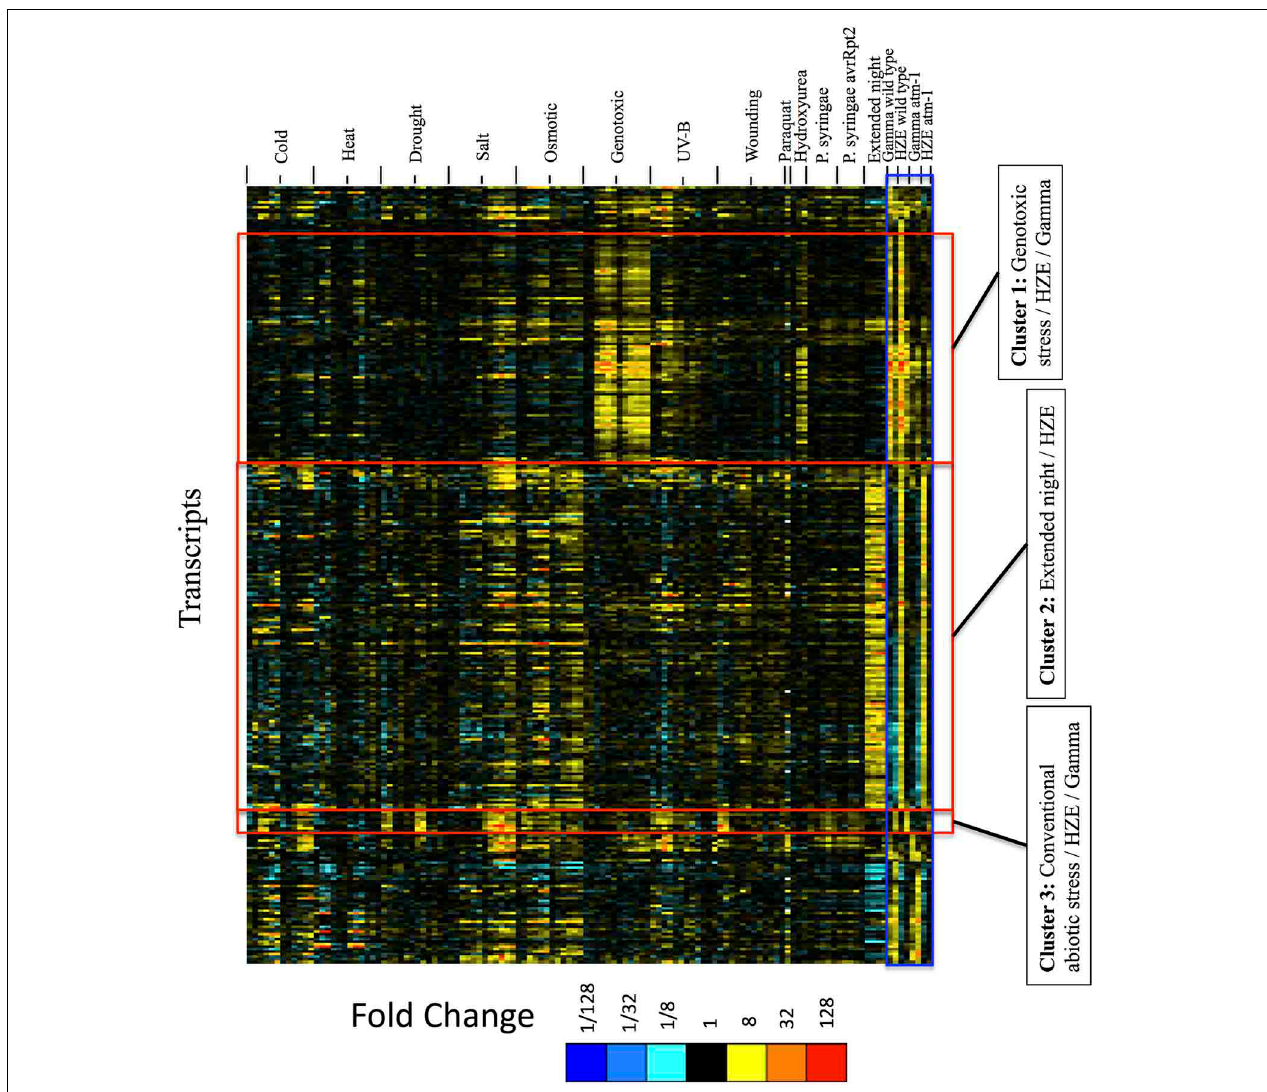
FIGURE 6 | Expression profiles of IR-induced transcripts, across abiotic and biotic stresses, clustered by the expression profiles across IR experimental conditions only. For the set of all transcripts strongly induced at 1.5 or 24h after IR treatment (fold change > 4 and adjusted p -value < 0.05 in response to HZE or gamma radiation, for WT or atm-1 plants), we display